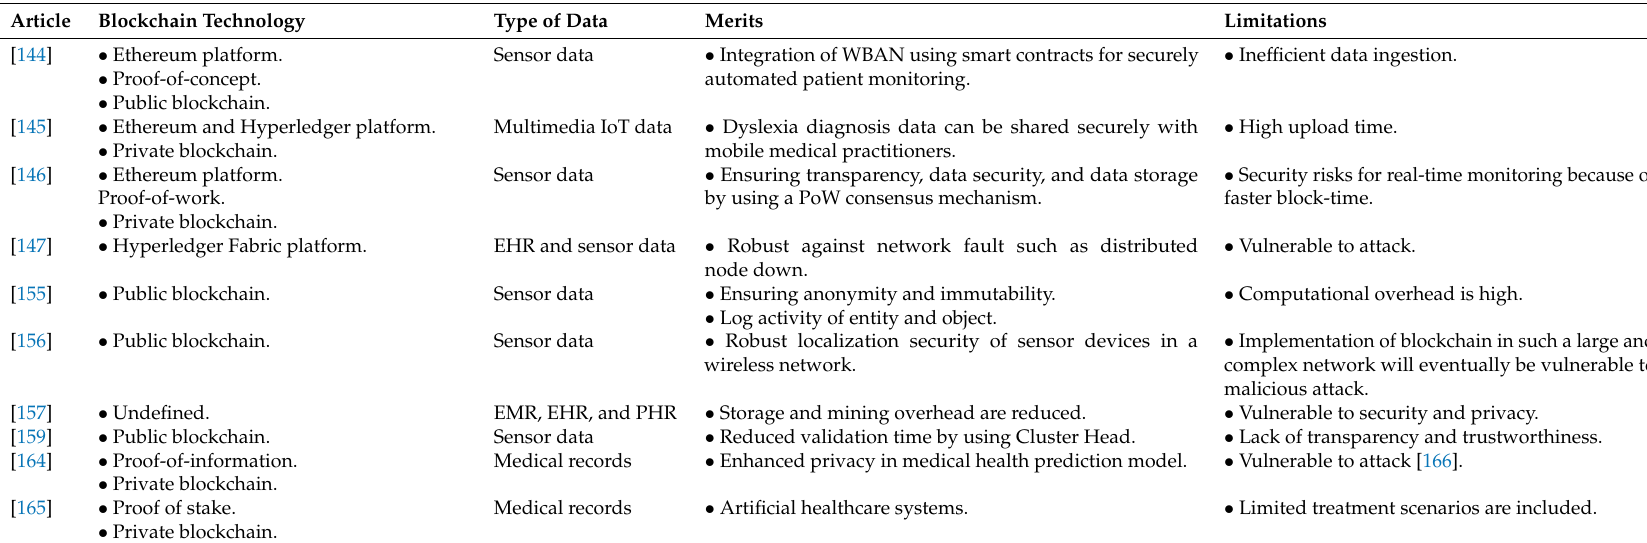
Table 3. Comparison of the internet of medical things mechanisms for healthcare in the